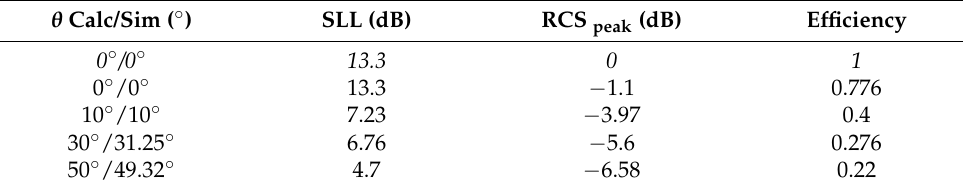
Table 2. Parameters for steering angles θ at 12 GHz.